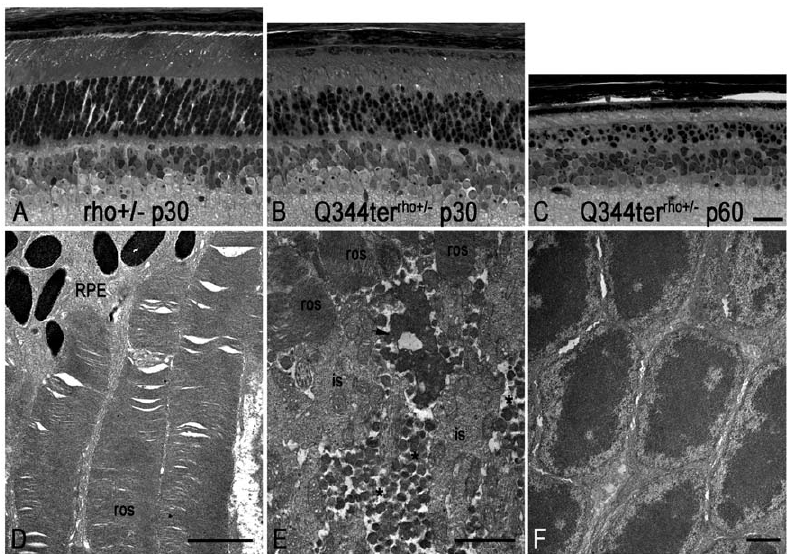
Figure 2. Q344ter transgene causes retinal degeneration independent of light. Images of retinal sections from epoxy-embedded eyecups were taken just above the optic nerve region from Q344ter rho + / 2 ( B, C ) and their transgene-negative littermate control ( A ) mice at the indicated ages. All mice were born and reared in the dark. ( D ) Rod outer segment structure from control transgene-negative rho + / 2 mice. ( E ) Vesicular structures (asterisks) within the interphotoreceptor space of Q344ter rho + / 2 retina. Arrow points to a degenerating structure. ( F ) Outer nuclear layer of Q344ter rho + / 2 retina is devoid of vesicles. Scale bar in C (20 m m) is also representative for panels A and B. Scale bar =1 m m for D, E, and F. ros, rod outer segment; RPE, retinal pigmented epithelium.